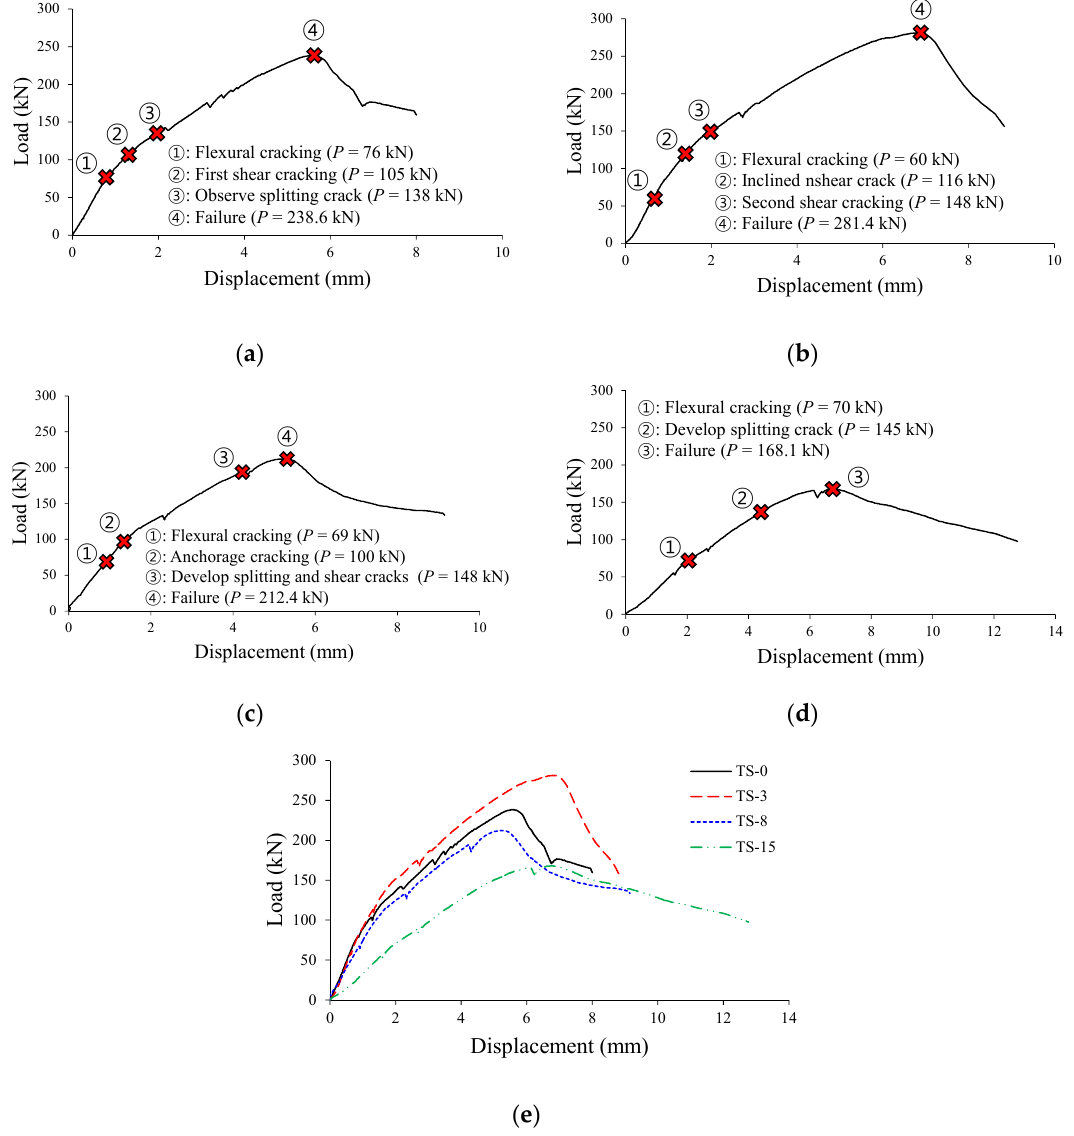
Figure 8. Load-displacement responses of TS series specimens. ( a ) TS-0 specimen; ( b ) TS-3 specimen; ( c ) TS-8 specimen; ( d ) TS-15 specimen; ( e ) Comparison of TS series test results.